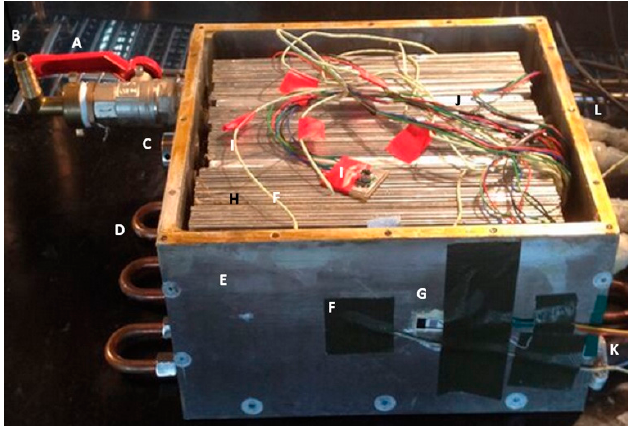
Figure 1. Housing of the physical simulated battery system (PSBS) ( A : Ball valve, B : Nozzle, C : PCE, D : U profile on the cold plate, E : housing, F : thermocouple, G : dew sensor, H : 17 mimicked cells, I : pressure sensor, J : cables for humidity sensor, K : outlet of the coolant, L : inlet of the coolant).